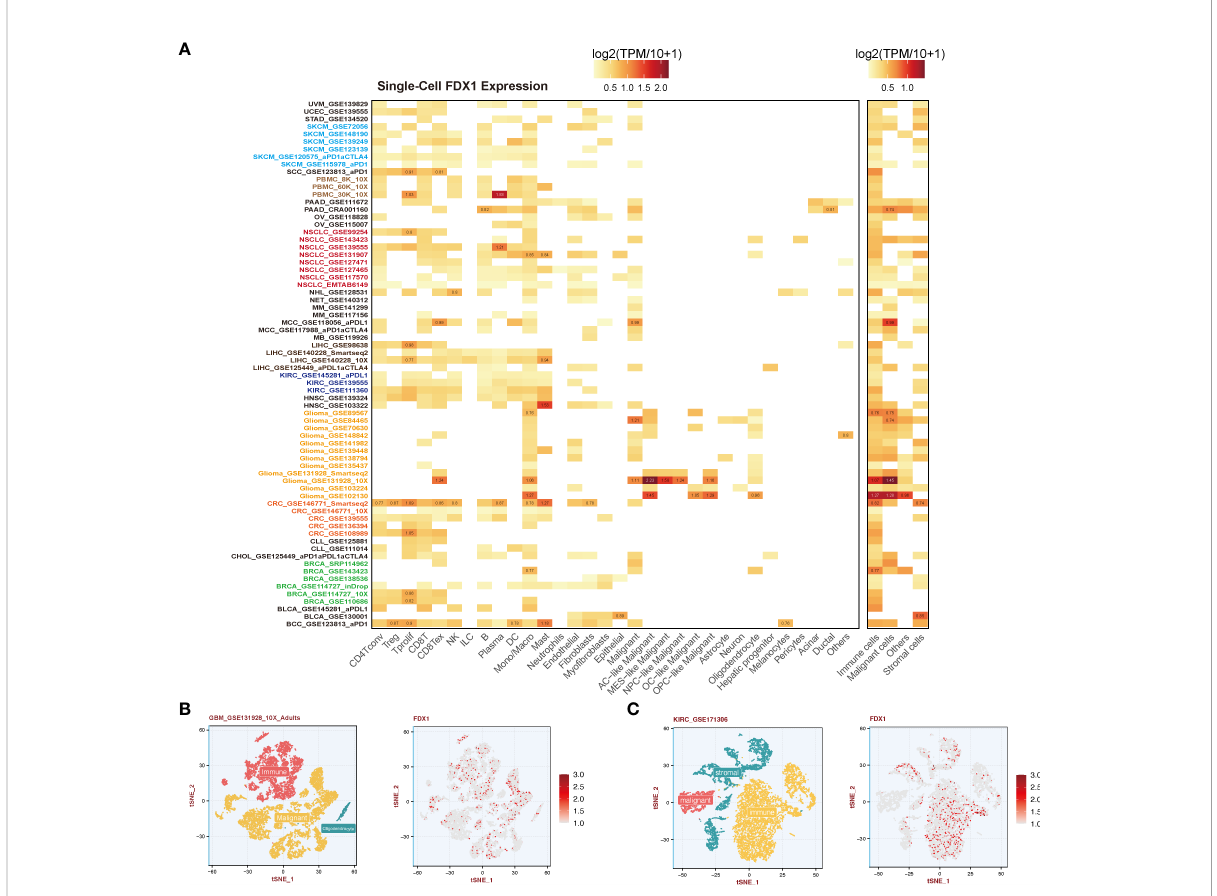
FIGURE 5 Single-cell analysis of FDX1 expression. (A) Left: FDX1 expression in different cells. Right: FDX1 expression based on malignancy classi fi cation. (B, C) Single-cell pro fi le and FDX1 expression in GBM and